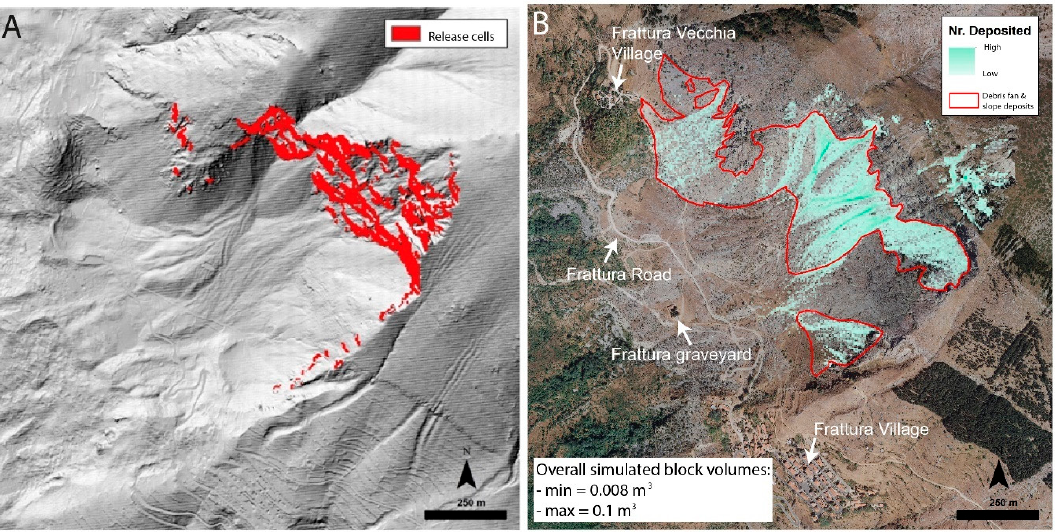
Figure 13. ( A ) Release cells (in red) used for rockfall simulations. ( B ) Simulation carried out with DFN 1 derived block volumes variable from 0.008 to 0.1 m 3 and showing the number of deposited blocks (“Nr. Deposited” in the legend).